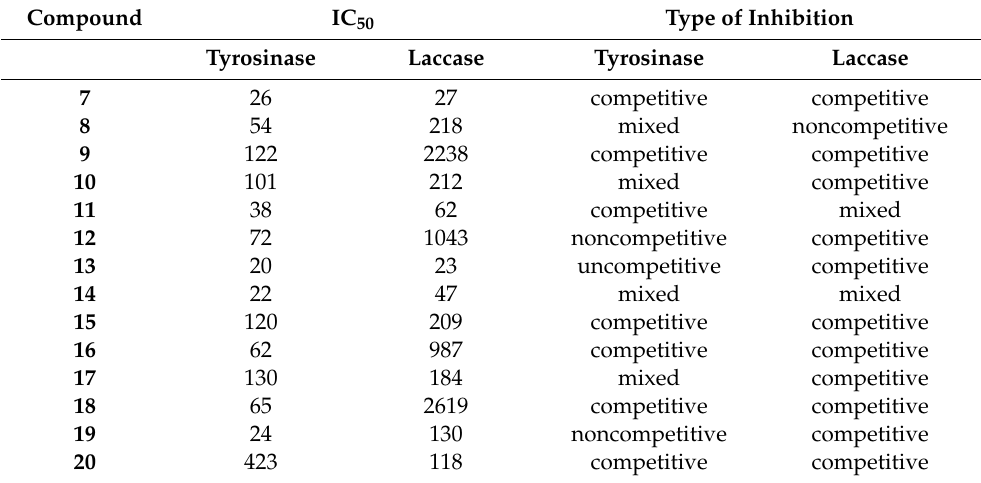
Table 1. Calculated IC 50 of each compound on tyrosinase and laccase enzymes and type of inhibition exerted. Concentrations are expressed in